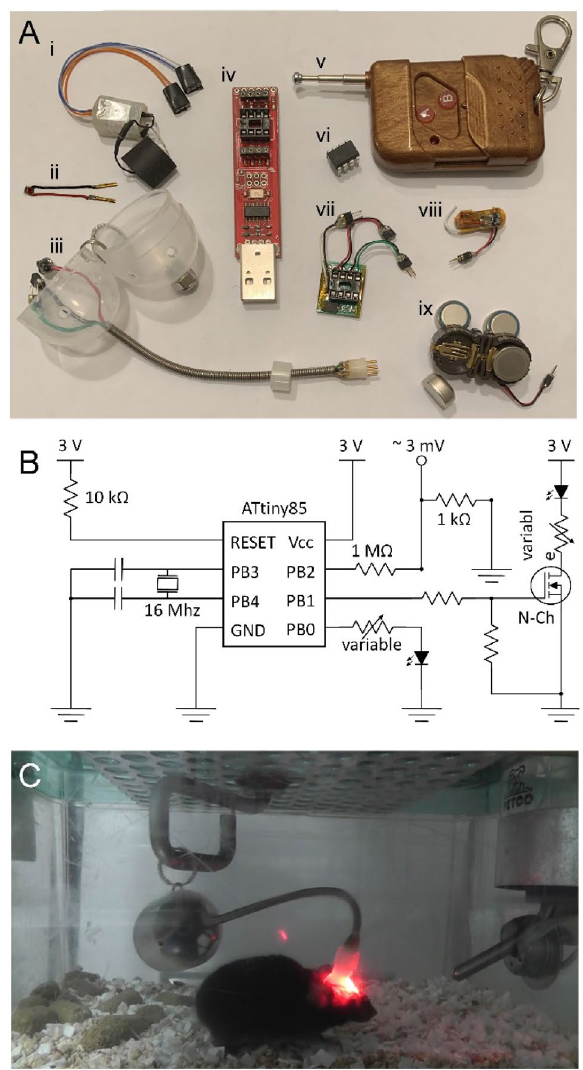
Figure 6. Optogenetic system for activating neurons locally in the cerebral cortex in mice. Components of the system are shown in A. Biopotentials are recorded by the transmitter (i). Light stimulation is produced by a high-power LED (ii). The system employs a special apparatus for connecting with the animal (iii). A programmer is used to generate pattern of optogenetic stimulation (iv). A remote controller is used to turn the optogenetic system on or off (v). ATTINY85 microcontroller (vi), PCB supporting ATTINY85 socket, crystal oscillator, and resistors for controlling the output voltage (vii), 433 MHz receiver module (viii), and battery holder with 675 zinc-air batteries (ix) are required to operate the system. A circuit diagram for generating different patterns of signals is presented in B. Pins PB3 and PB4 of the ATTINY85 microcontroller are used for connecting with the external crystal oscillator. Pins PB0, PB1 and PB3 can be programmed to power an LED either directly (PB0) or via a N-channel MOSFET (PB1). Additionally, a low voltage signal can be generated (PB2). Simultaneous recording of EEG/EMG and optogenetic stimulation in a freely moving mouse were performed in a regular mouse cage placed on the top of a wireless receiver (C). ATTINY85-based circuit and batteries were located in a container connected with the mouse. It was supported by the apparatus that was counterbalanced and rotated circularly to eliminate pressure on the